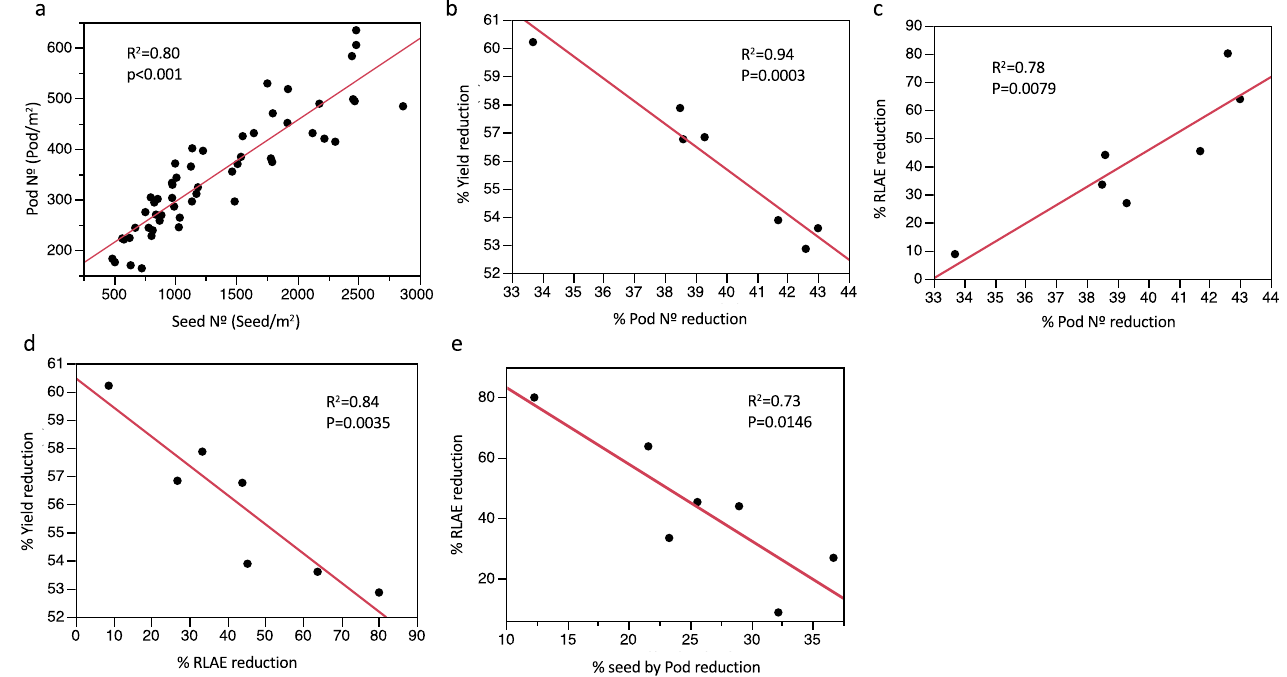
Figure 6. Relationship between ( a ) pod number (Pod N°) with seed number (Seed N°), ( b ) % yield reduction and ( c ) % RLAE reduction with % pod number reduction, ( d ) % yield reduction with % RLAE reduction, ( e ) % RLAE reduction with % seed-by-pod reduction. For ( a ), the dot of the graph represents replicates from each landrace. For the rest, the dot represents the calculated relationship for each landrace minus Coscorron and Pinto. A linear fit is shown as a red line. The regression coefficient (R 2 ) and significance are also shown.